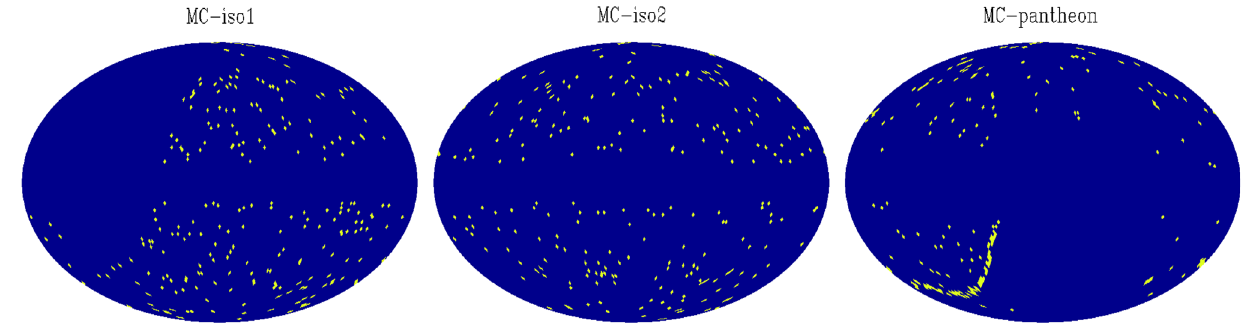
Fig. 1 Left panel: the sky distribution of SN at 0 . 023 < z < 0 . 150 following the MC-iso1 prescription. Central panel: same as the left panel, but for the MC-iso2 instead. Right panel: a realization assuming the original SN celestial distribution, corresponding to the MC-pantheon case